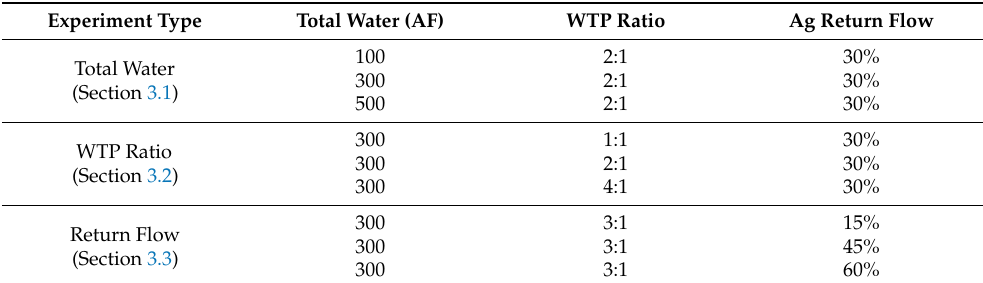
Table 1. Summary of experiments designed to evaluate system response to total water, WTP ratios, and return flow